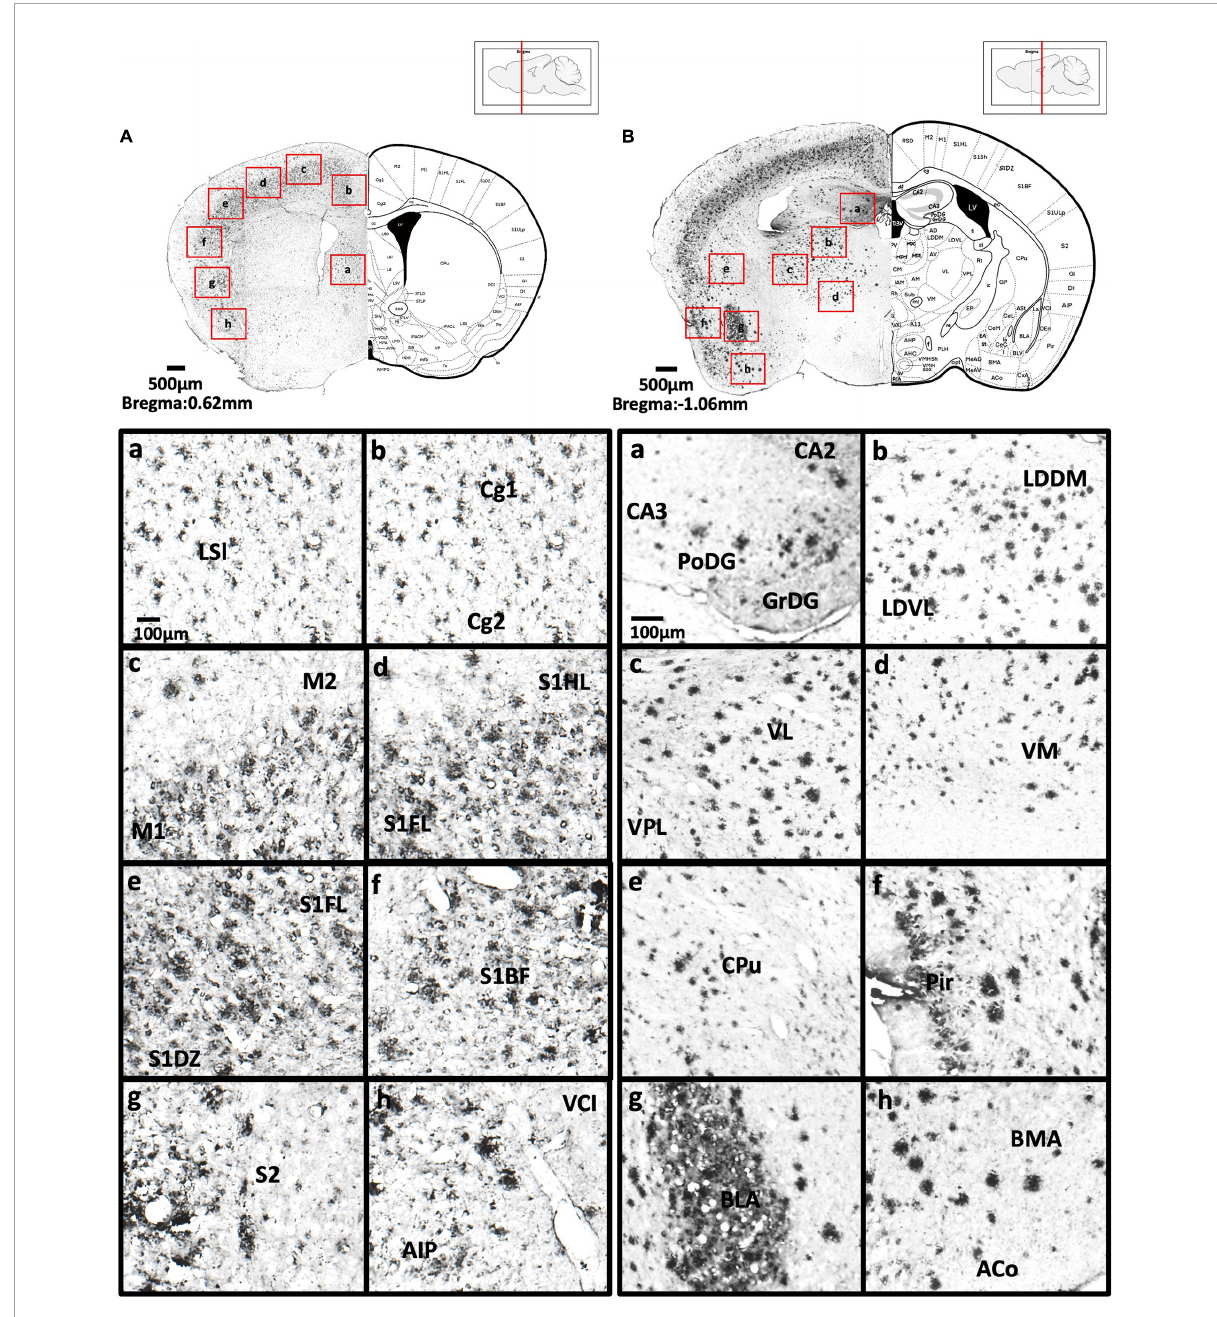
FIGURE4 (A) Coronal section through the cerebral cortex showing A β deposition in the intermediate part of the lateral septal nucleus (a), area 1 and area 2 of the cingulate cortex (b), primary motor cortex and secondary motor cortex (c), hindlimb region and forelimb region of somatosensory cortex (d), forelimb region and dysgranular zone of somatosensory cortex (e), barrel field of the somatosensory cortex (f), secondary somatosensory cortex (g), ventral part of claustrum and posterior agranular insular cortex (h). (B) Coronal section through the forebrain showing A β deposition in CA2 field, CA3 field and dentate gyrus (a), dorsomedial and ventrolateral areas of the laterodorsal thalamic nucleus (b), ventrolateral thalamic nucleus, ventral posterolateral thalamic nucleus (c), ventromedial thalamic nucleus (d), caudate putamen (e), piriform cortex (f),